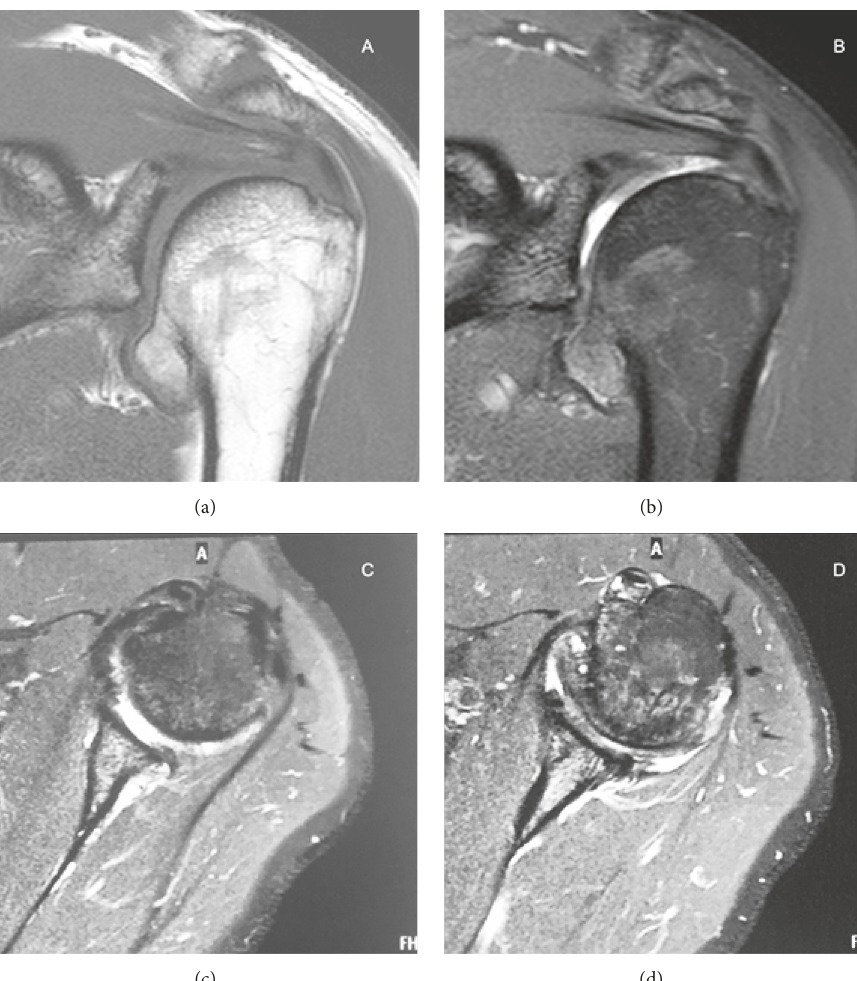
Figure 4: MRimages of the left shoulder revealed theinferomedial mass projecting toward theinferior capsular recess,with sharpeningof the articular cartilage of the humeral head, but no signs of OA. Cartilaginous components of the tumor showed intermediate T1-weigthed signal and hyperintense proton density- (PD-) weighted signal. In contrast, bone marrow of the tumor showed hyperintense T1-weighted signal and intermediate-to-low PD-weighted signal. (a) T1-weigthed coronal image, (b) PD-weighted coronal image, and (c) and (d) T2-weigthed axial